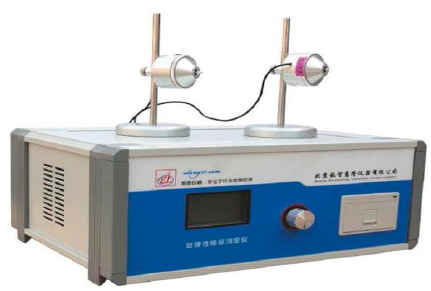
Figure 3. Concrete dynamic modulus of the elasticity tester (DT ‐ W18).